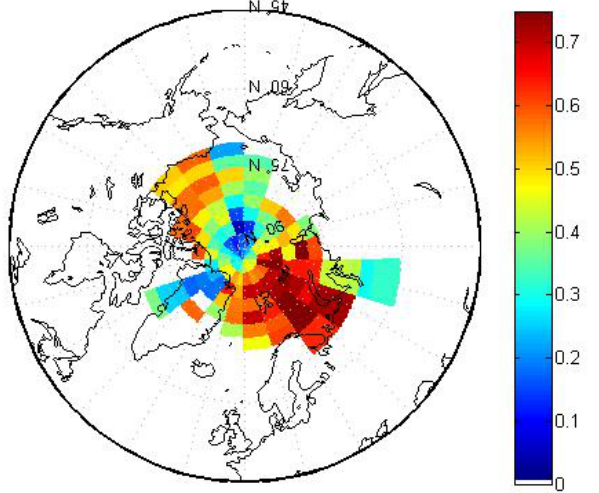
Fig. 7. PSCF analysis of the Marine Biogenic Factor.